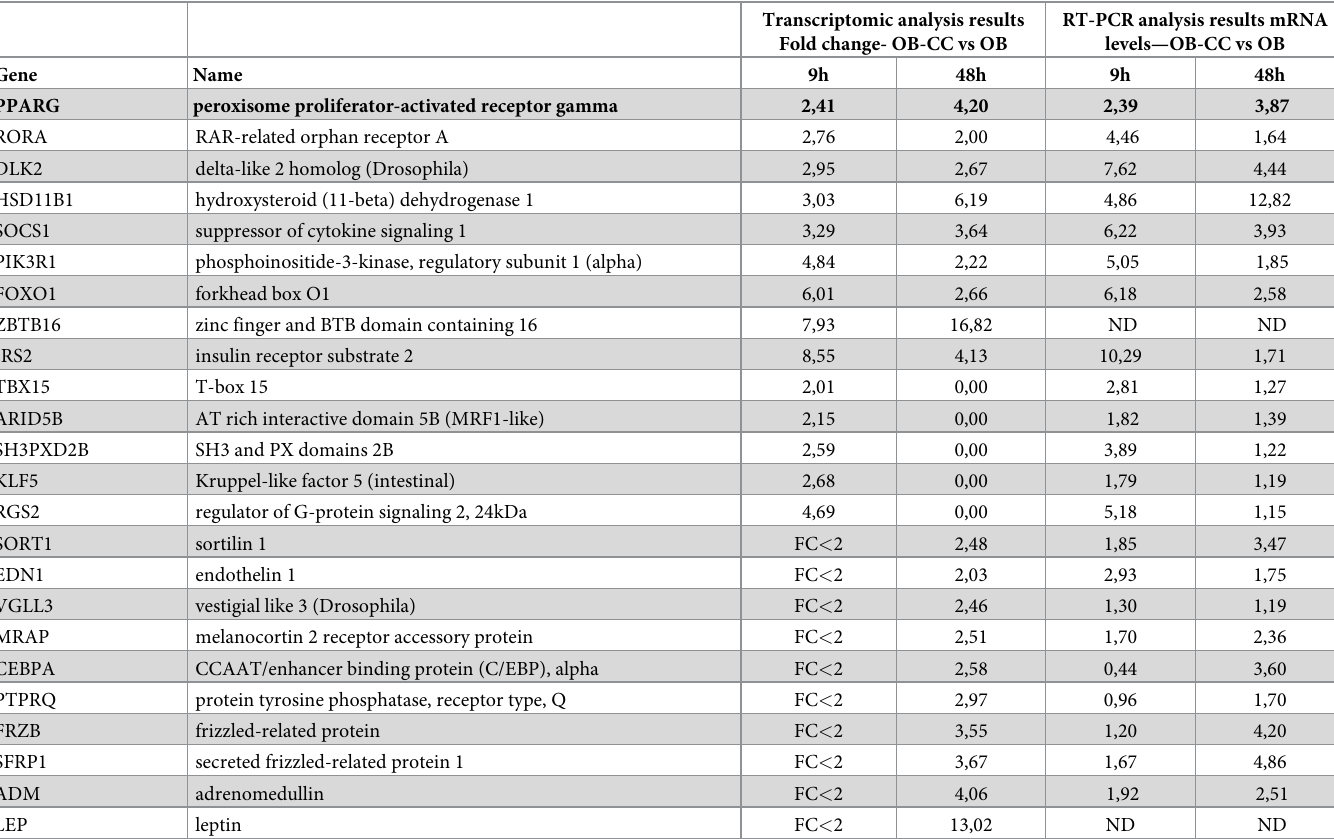
Table 3. Validation of differential expression of genes associated with differentiation of adipocytes using quantitative RT-PCR analysis.